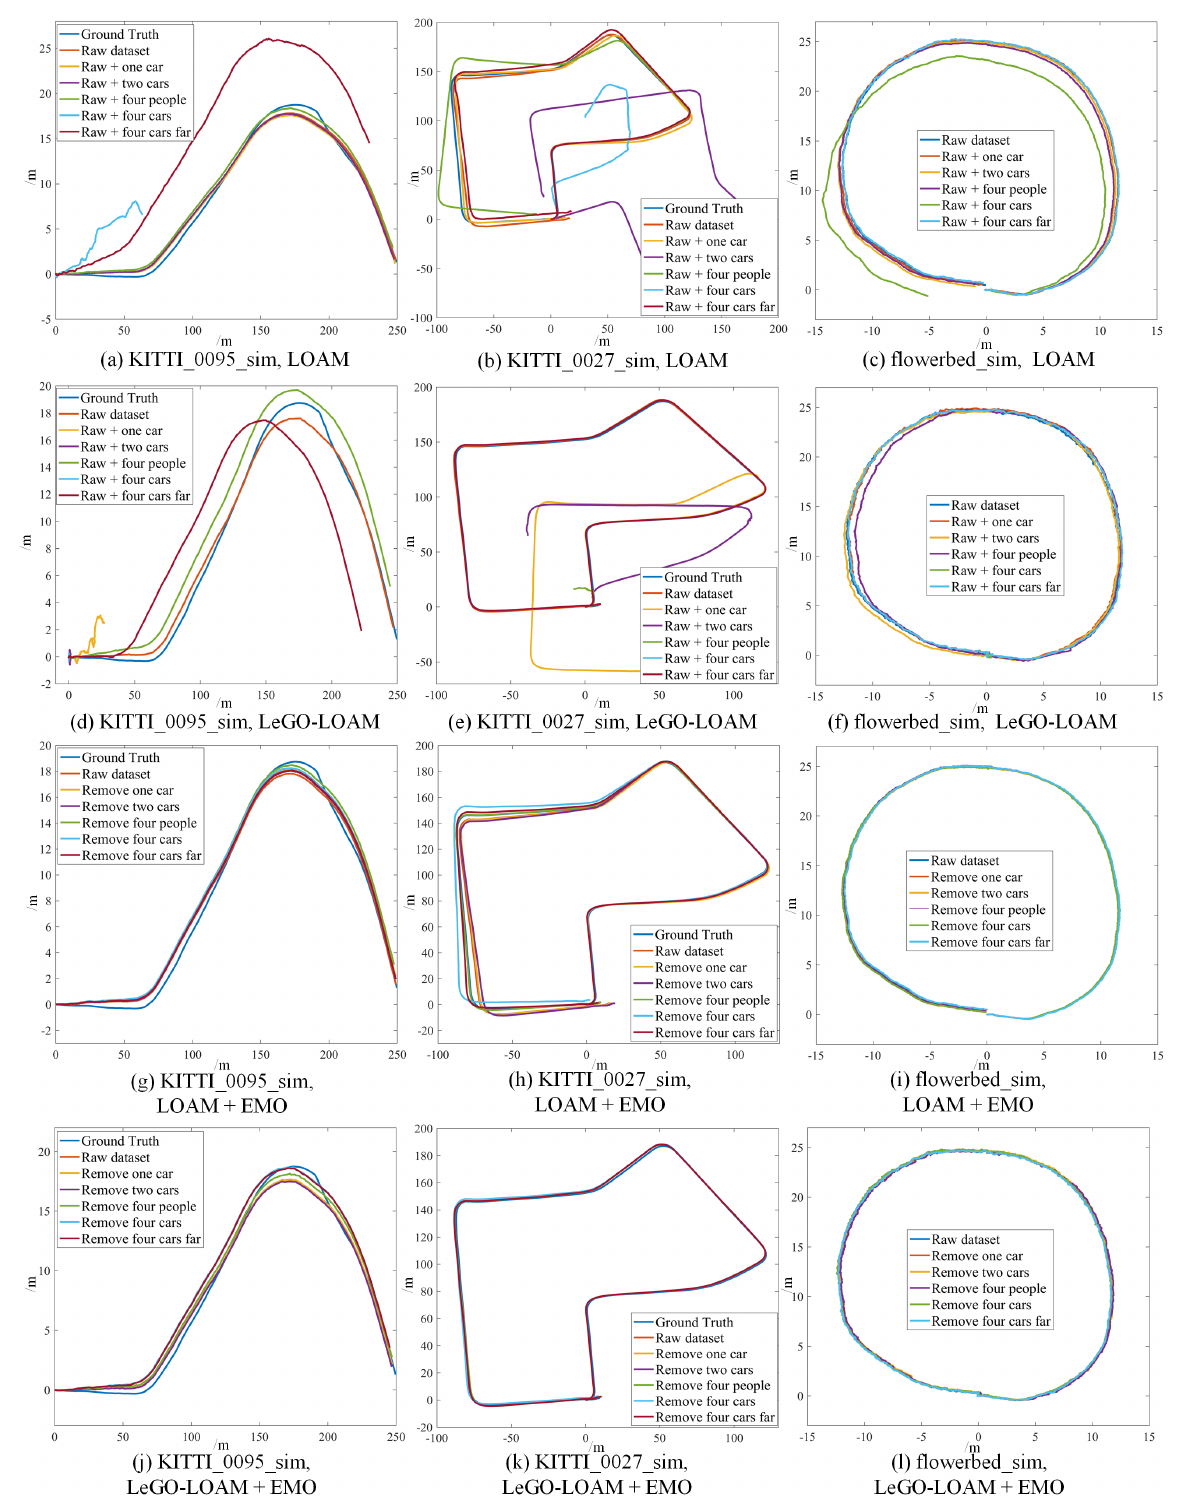
Figure 13. The odometry results of [original LOAM] ( a – c ), [original LeGO-LOAM] ( d – f ), [LOAM + EMO] ( g – i ) and [LeGO-LOAM + EMO] ( j – l ) in different simulated scenarios based on KITTI_0095_sim, KITTI_0027_sim and flowerbed_sim. Before removing the dynamic objects, more dynamic objects result in worse odometry drift or even estimation failure ( a – f ). After removing the moving objects with our method, the two algorithms yield evidently improved odometry accuracy in all the scenarios ( g – l